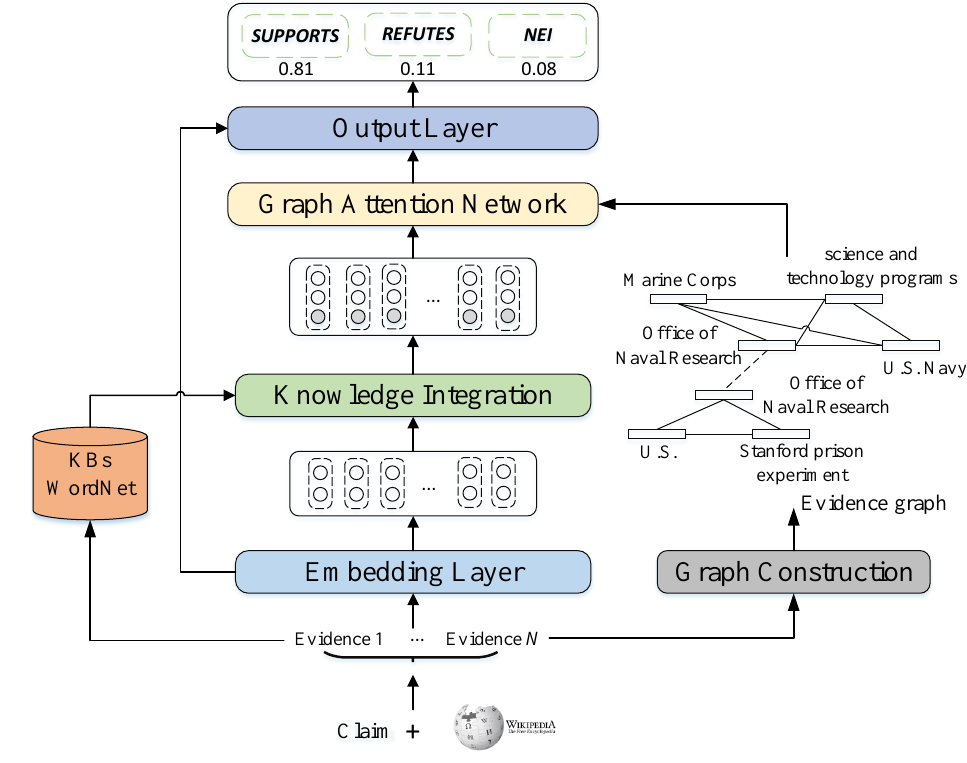
Figure 2. Structure of the KEGA